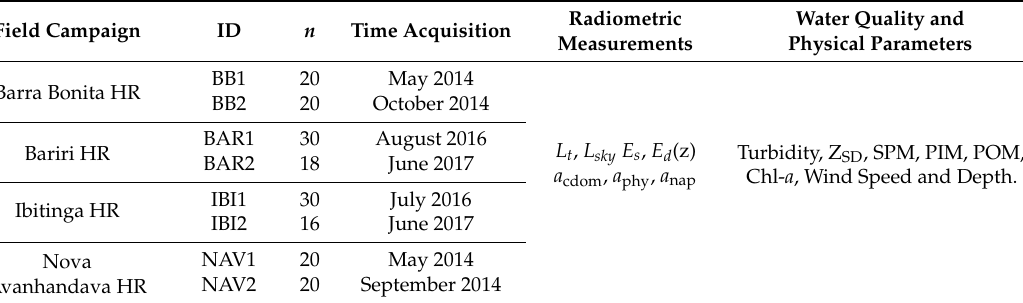
Table 1. Sampling descriptions from each fieldwork in Barra Bonita, Bariri, Ibitinga and Nova Avanhandava reservoirs from TCSR, and respective water quality parameters and radiometric measurements. L t is the total radiance, L sky is the incident sky radiance (both in W · m − 2 · sr − 1 · nm − 1 ), E s is the downwelling irradiance incident onto the water surface and E d is the downwelling irradiance (both in W · m − 2 · nm − 1 ). Radiometric Field Campaign ID n Time Acquisition